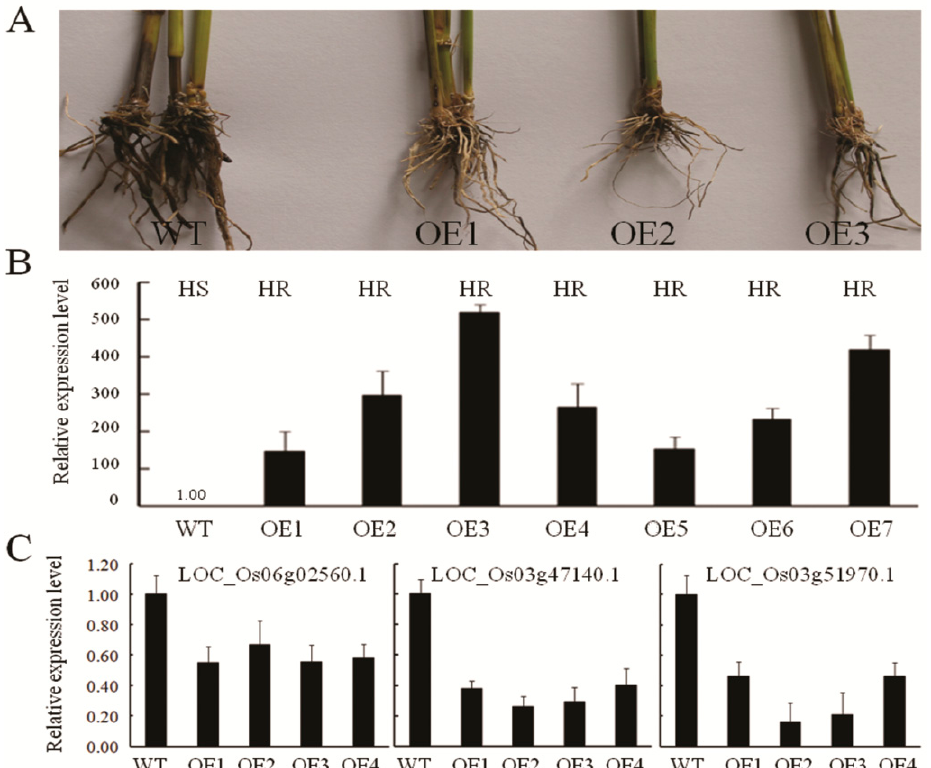
Figure 7. Overexpression of the osa-miR396f precursor in rice enhanced resistance to D. zeae . ( A ) Resistant phenotype to D. zeae in overexpressing transgenic plants; ( B ) The relative expression level of osa-miR396f precursor and resistant reactions in overexpressing rice. HS, highly susceptibility. HR, highly resistance; ( C ) The expression levels of three targets of osa-miR396f were inhibited in overexpressing rice. WT, wild-type rice Nipponbare. OE1-7, the osa-miR396f precursor- overexpressing rice plants.